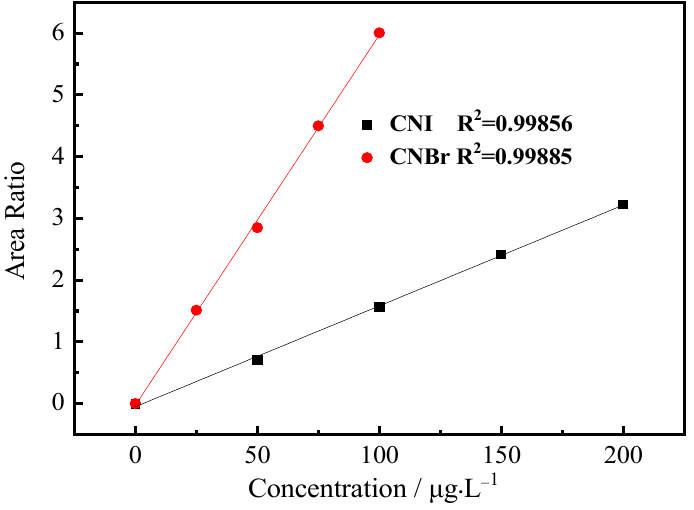
Figure 2. Calibration curves of CNI and CNBr.